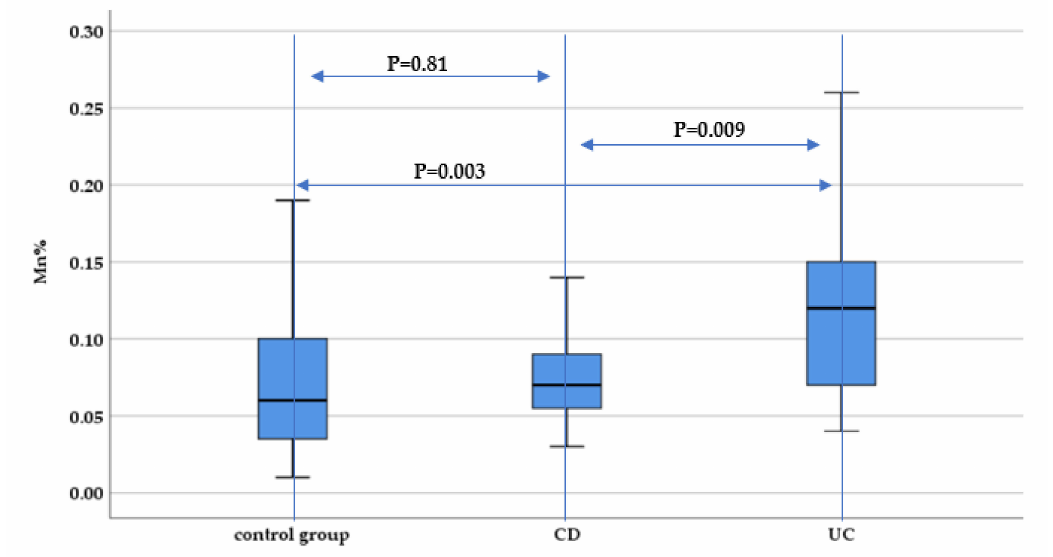
Figure 4. Evaluation of hair manganese concentration (Mn%) between IBD subtypes (UC and CD) and the control group. The hair iron concentration was statistically significantly lower both in CD and UC patients compared to the control group ( p < 0.001). However, no statistically significant difference between UC and CD patients regarding hair iron concentration was identified ( p = 0.716) (Figure